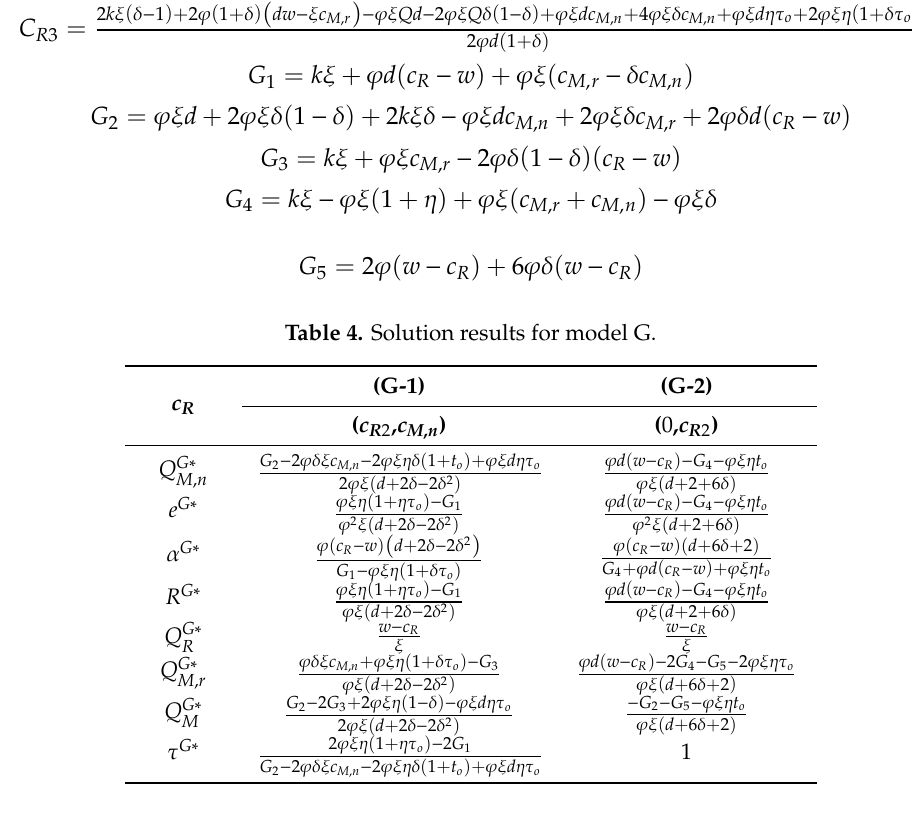
Table 5. Relationships between variables and parameters in model